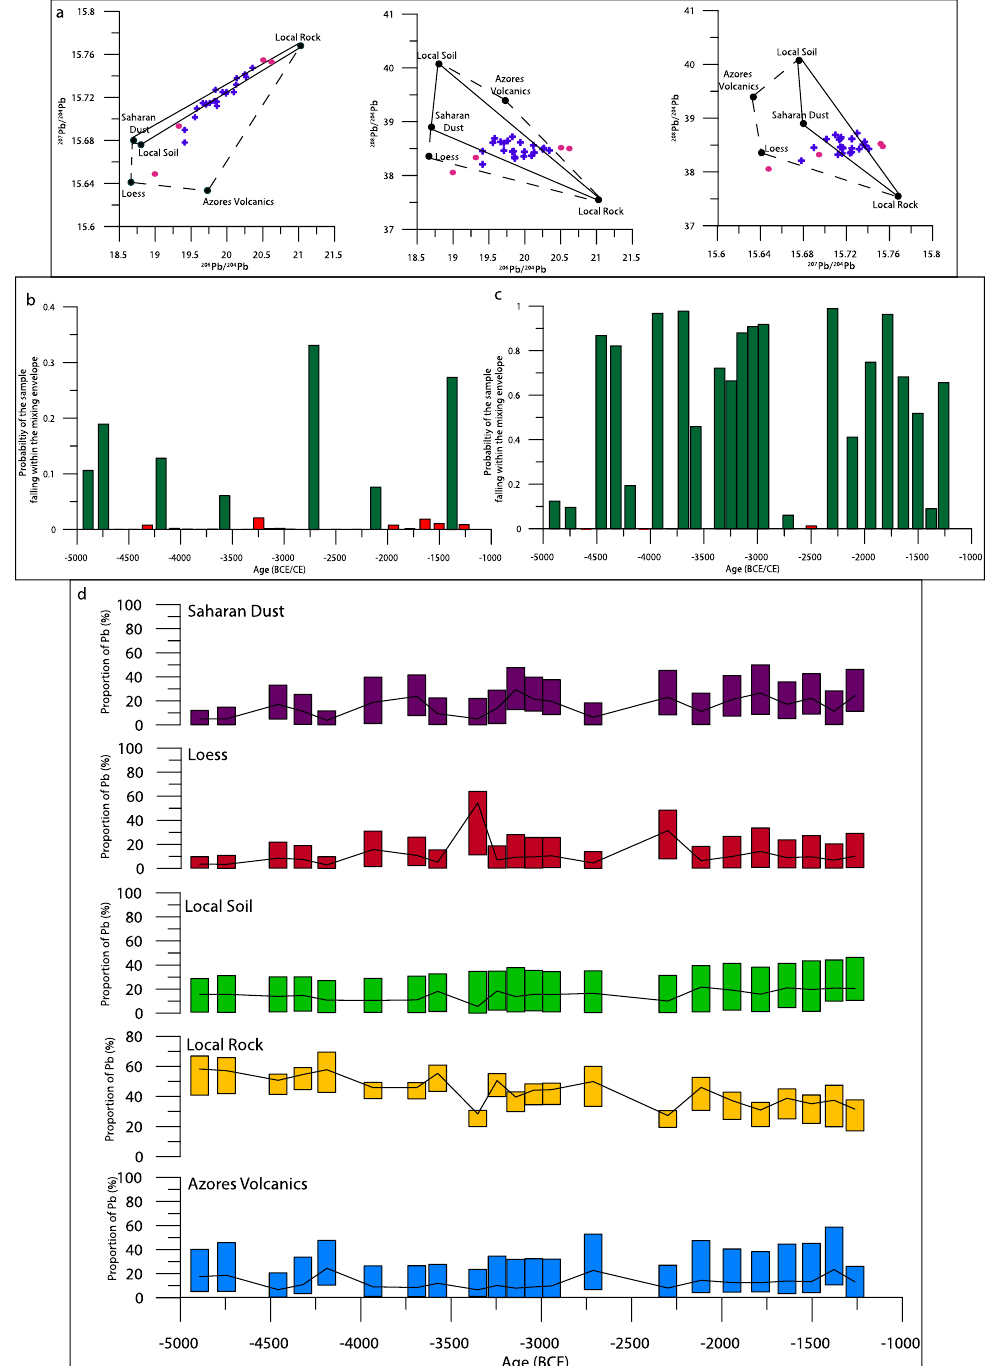
Figure 3. Convex hulls ( a ) from pre-anthropogenic dust tracing. Black circles denote sources used to reconstruct valid substrate mixtures from Penido Vello between 5000–1200 BCE 52 . Mixing envelopes as defined by the original publication are marked with solid black lines, whilst additional sources as suggested here result in mixing envelopes denoted by black dashed lines. Samples which fall within the convex hulls are marked in blue whilst those which fall outside one or more are pink, and have not been modelled. ( b ) Displays the output from the envelope mixing model using the original publications, ( c ) with additional sources. ( d ) Is the model output from the valid mixtures, displaying changing source contributions to the Pb contained within the mixture. In each case, the rectangle indicates the range of model outputs, with the upper and lower bounds signifying the 2.5% and 97.5% credible intervals, while black lines trace the mean